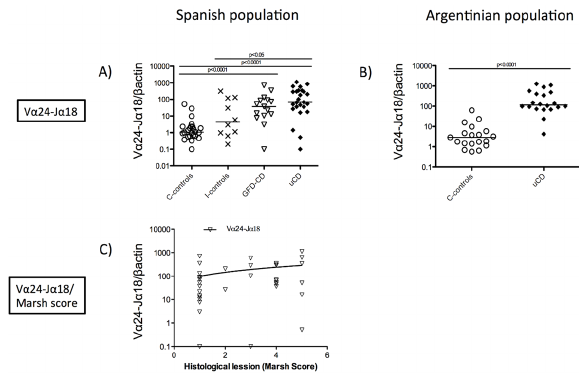
Figure 2. Increased duodenal V α 24 ‐ J α 18 mRNA expression in untreated and treated celiac disease patients. Expression levels of V α 24 ‐ J α 18 mRNA in duodenal biopsies indicated by the ratio V α 24 ‐ J α 18/ β actin in arbitrary units (AU), in untreated Celiac Disease (uCD), Gluten Free Diet ‐ CD patients (GFD ‐ CD), inflamed non ‐ CD controls (I ‐ controls) and non ‐ inflamed non ‐ CD controls (C ‐ controls) in the Spanish population ( A ) and in uCD and C ‐ controls in the Argentinian population ( B ). Statistically significant differences are shown (two tailed Mann ‐ Whitney U test; Krustall ‐ Wallis test). Horizontal bars are median values. Correlation between the degree of histological lesion (Marsh score) and the expression level of V α 24 ‐ J α 18 mRNA in CD patients. (1: Marsh 0 ‐ I, 2: Marsh II, 3: Marsh